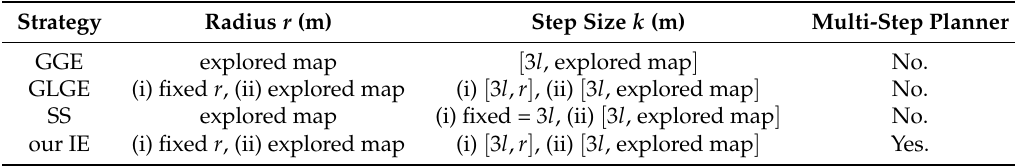
Table 4. Evaluated strategies compared against our Integrated Exploration (IE) strategy.